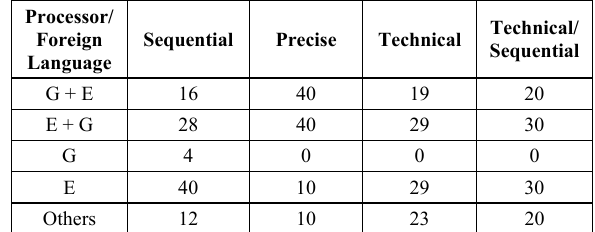
TABLE II. F OREIGN L ANGUAGES THE R ESPONDENTS S